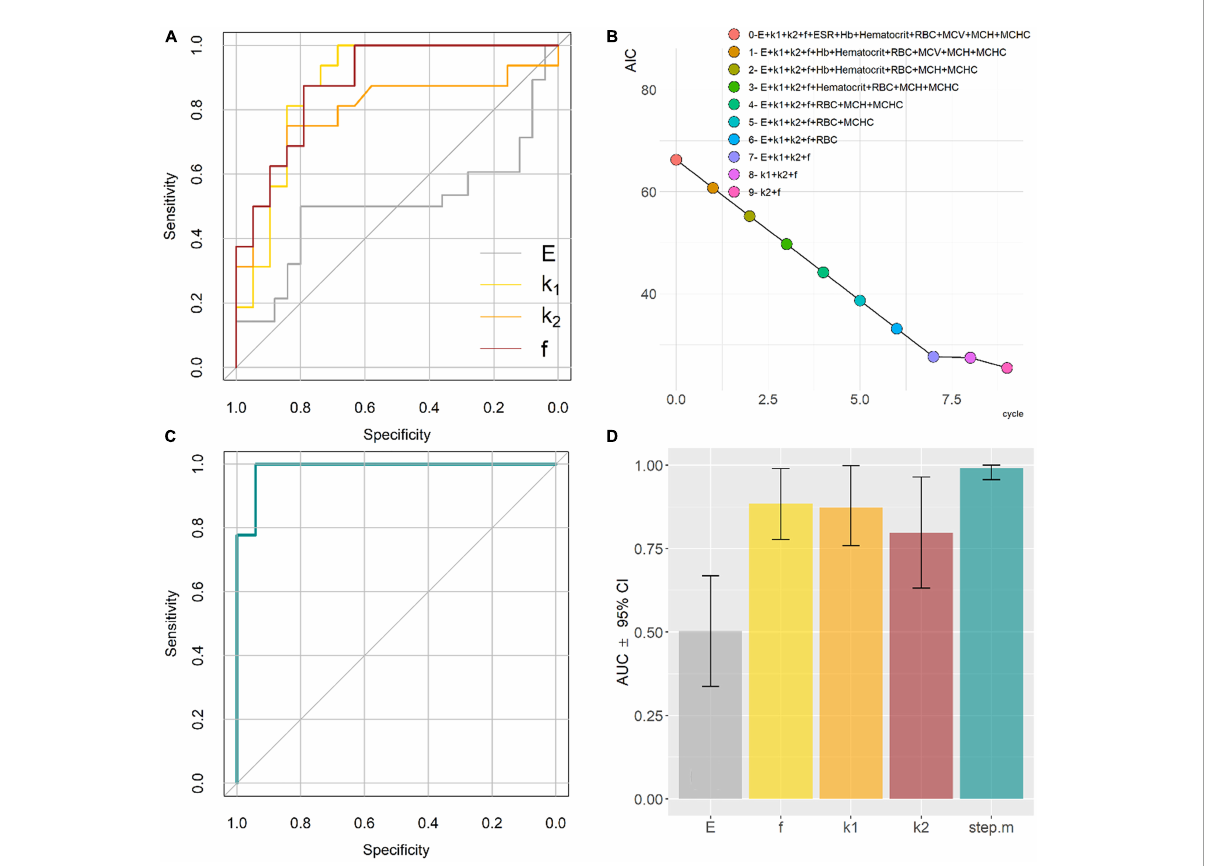
FIGURE4 Receiving operator characteristic (ROC) curves for the four selected mechanical biomarkers (A) ; Evolution of the Akaike’s Information Criterion (AIC) during a stepwise logistic regression performed on all the measured mechanical and biochemical parameters (B) ; ROC curve calculated using the selected variables f and k2 (C) ; Areas under the curves (AUC) values for the four mechanical parameters and the stepwise model (D)